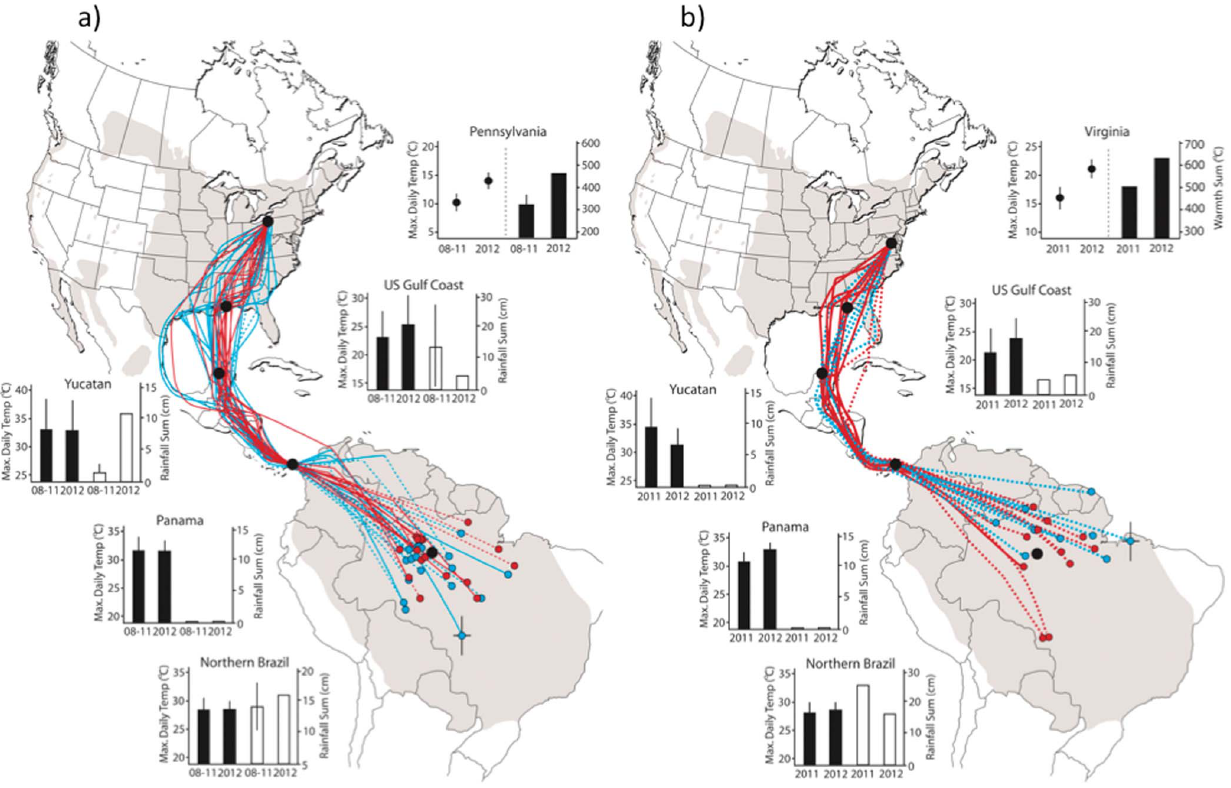
Figure 1. Spring migration routes and en route temperatures and rainfall for purple martins. Birds were tracked from two breeding populations a) Pennsylvania (41.8 u N, 79.9 u W) and b) Virginia (38.61 u N, 77.26 u W). Spring routes shown in red (2012) and blue lines (2008-11 PA; 2011 VA). Dashed lines show estimated route based on longitude when latitude was uncertain due to equinox. Black circles show locations of en route temperature and rainfall measurements and correspond to adjacent graphs showing mean 6 SD temperature during passage (10 d pre-and post- median passage date) and rainfall sum (30 d pre-median departure/passage date; 6 SD where multiple years). Breeding site graphs (Pennsylvania and Virginia) show maximum daily temperature and spring warmth sum at breeding sites March 15– April 15 (circles show mean, bars standard deviation). Last winter roost locations in South America before spring migration are shown by red and blue circles. Error bars, shown for one bird on each map, are typical standard deviation in latitude and longitude for estimated winter